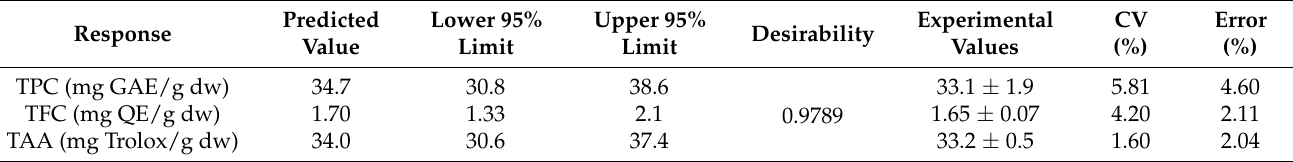
Table 5. Validation of the polynomial (quadratic) Box-Behnken model for conventional extraction by cornbelian cherry fruits.